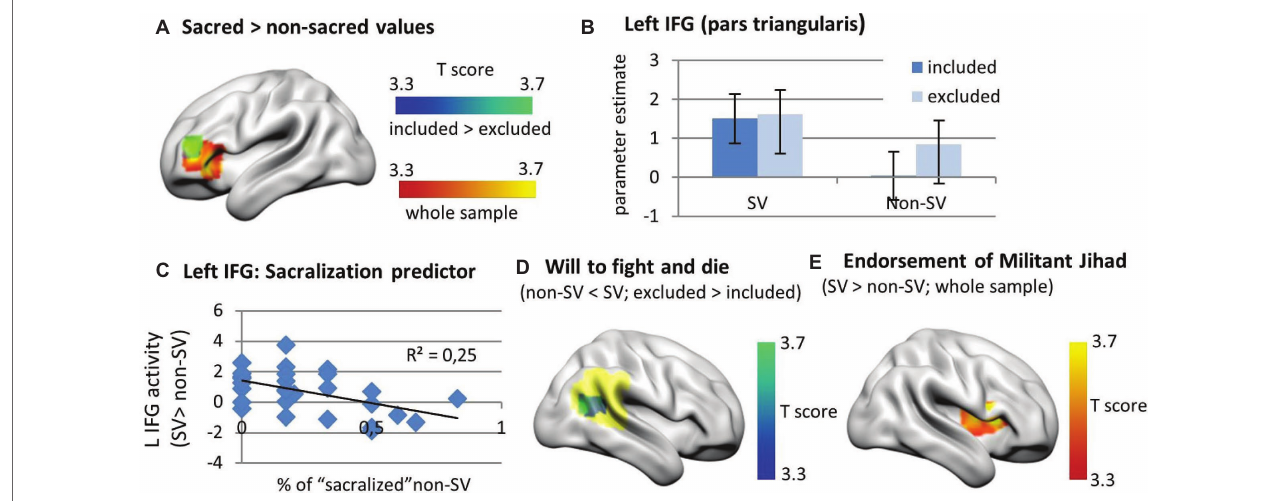
FIGURE 3 | Neuroimaging results including (A) higher activity in the left inferior frontal gyrus (IFG, pars triangularis) in the sacred compared to the nonsacred condition in the whole sample (results in red-yellow) and higher between-condition difference in left IFG activity in the included compared to the excluded group (small volume correction with left IFG cluster obtained in the whole sample analysis), (B) similar left IFG activity estimates in the sacred value versus baseline contrast in both groups, but higher left IFG activity estimates in the nonsacred value versus baseline condition in the exclusion versus inclusion group, explaining between-group left IFG activity differences shown in (A), (C) a negative correlation between left IFG activity differences between sacred versus nonsacred values and percentage of nonsacred values that became sacred in the postmanipulation sacredness reassessment ( r = − 0.496, p = 0.007, and N = 28), even after controlling for social exclusion ( r = − 0.485 and p = 0.010), (D) significantly lower right temporoparietal activity in response to willingness to fight and die for nonsacred versus sacred values in excluded compared to included participants after small volume correction by means of a right TPJ mask extracted from Neurosynth ( T = 4.34, p = 0.044 FWEc, single voxel p < 0.001, and mask shown in yellow), and (E) higher activity in the right insula ( T = 5.30, p < 0.001 FWEc, and single voxel p < 0.001), left insula ( T = 4.72, p = 0.005 FWEc, and single voxel p < 0.001), and right postcentral gyrus ( T = 4.96, p = 0.004 FWEc, and single voxel p < 0.001) during the sacred versus nonsacred value condition predicted by the “Endorsement of Militant Jihad” score in the whole